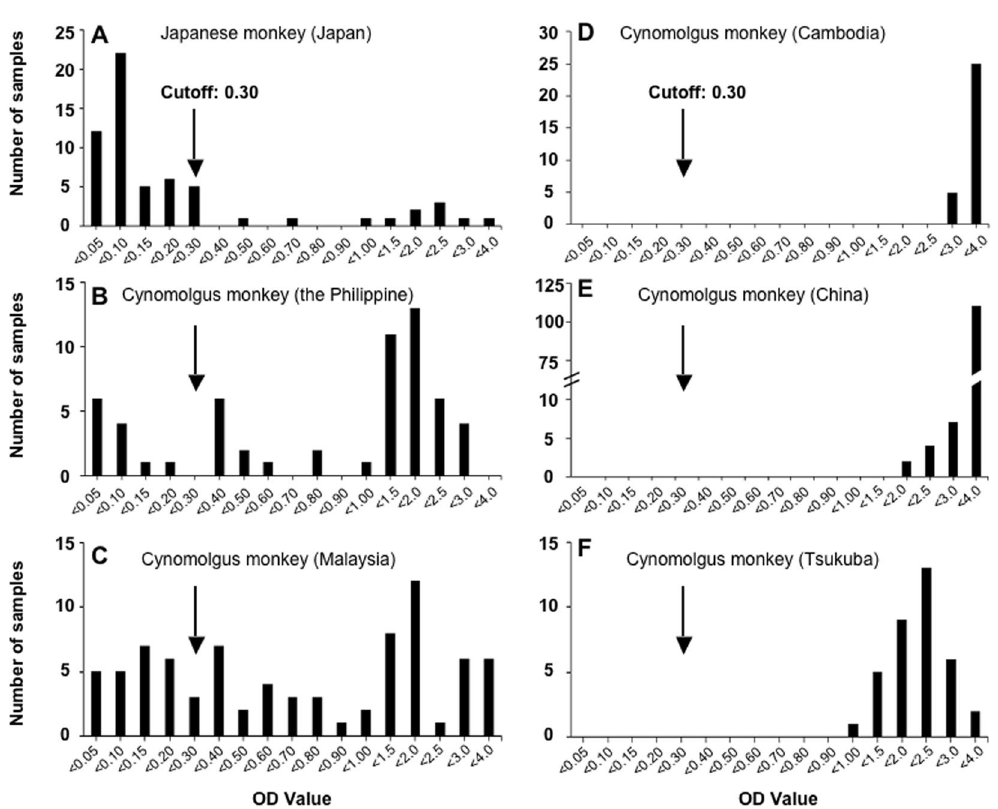
Figure 4. Detection of anti-SSV antibodies in monkeys. Anti-SSV IgG antibodies in 6 groups of monkeys were examined by ELISA using the purified Cam13 virus particles as the antigen. The number of samples for each OD value are plotted. The cutoff value is indicated by an arrow